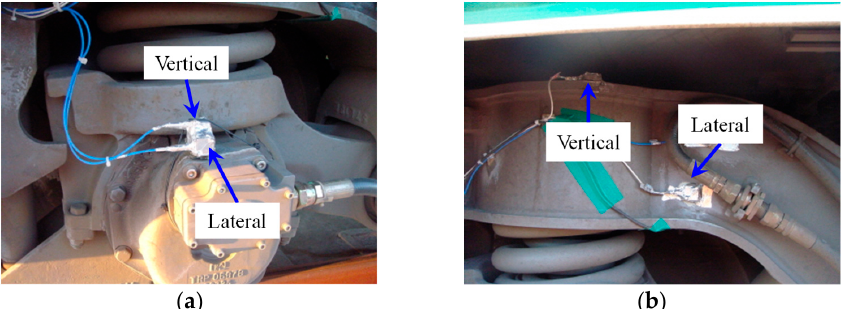
Figure 1. Accelerometers on axle box and bogie: ( a ) axle box-mounted accelerometers; ( b ) bogie- mounted accelerometers [12].